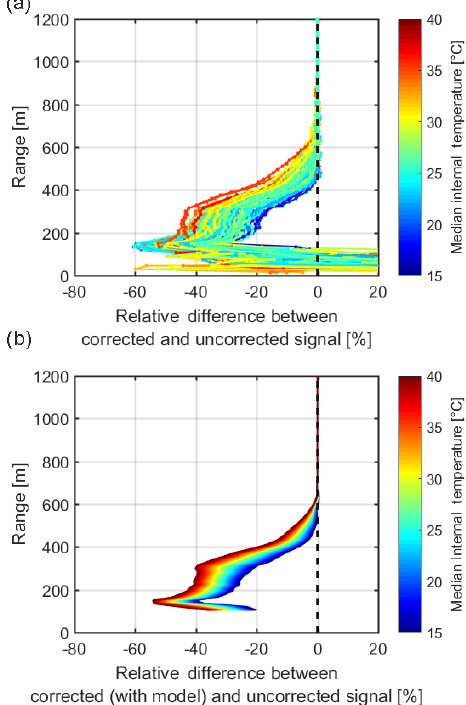
Figure 7. Relative difference between corrected and uncorrected signal. Upper panel: from measurements. Lower panel: with model. The colour represents the internal temperature of the